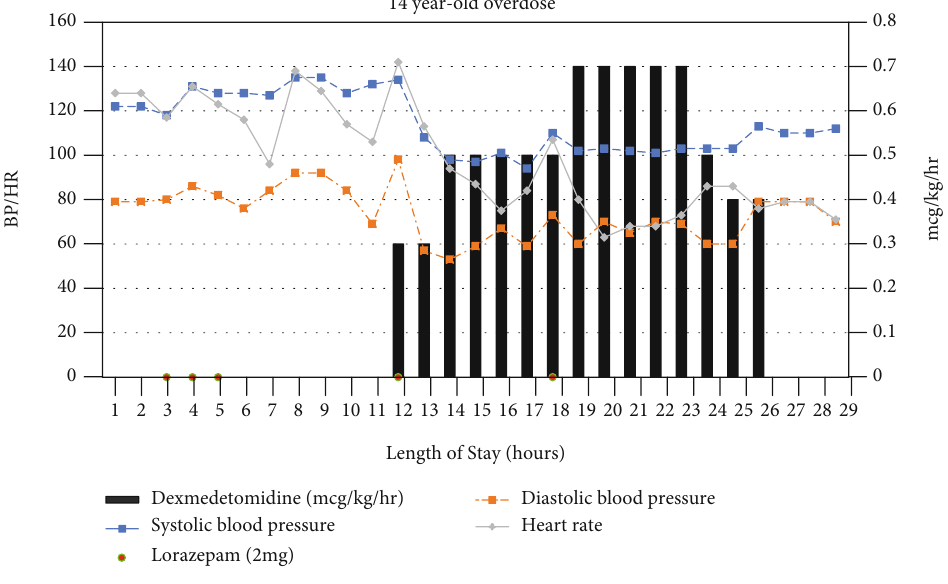
Figure 2: The patient had persistent tachycardia and hypertension despite multiple doses of lorazepam noted at hours 3-5. Dexmedetomidine was initiated at hour 12, and the patient had a signi fi cant improvement in vitals by hour 14 with mild increase in